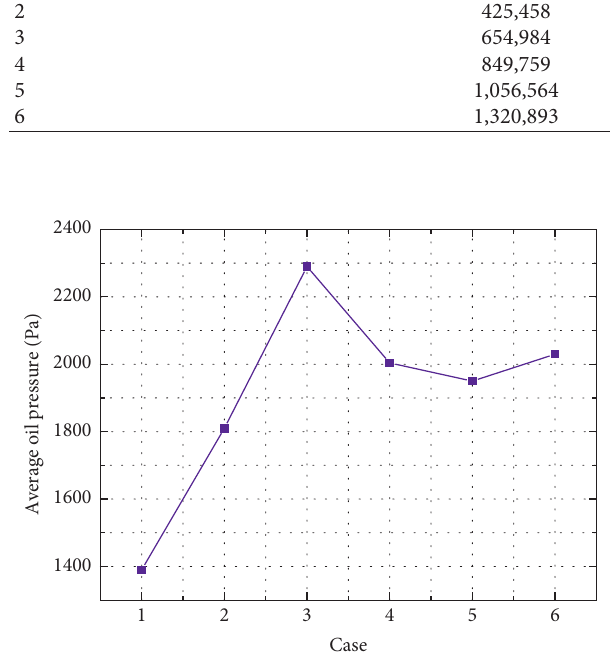
Figure 4: Average oil pressure under six